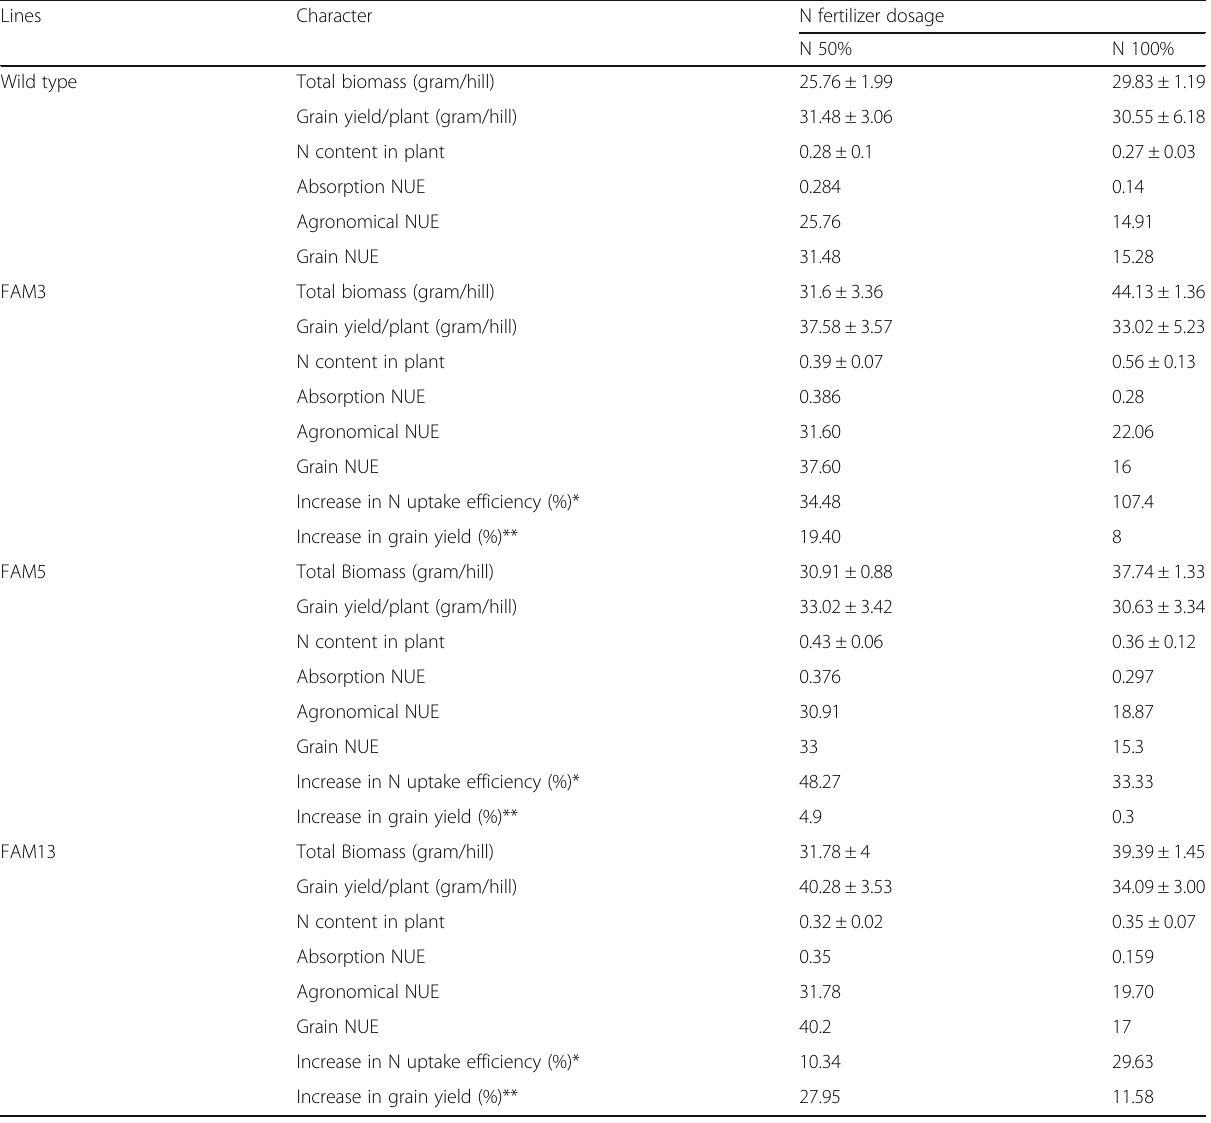
Table 4 Absorption, agronomic, and grain NUE values in CsAlaAT2 transgenic events